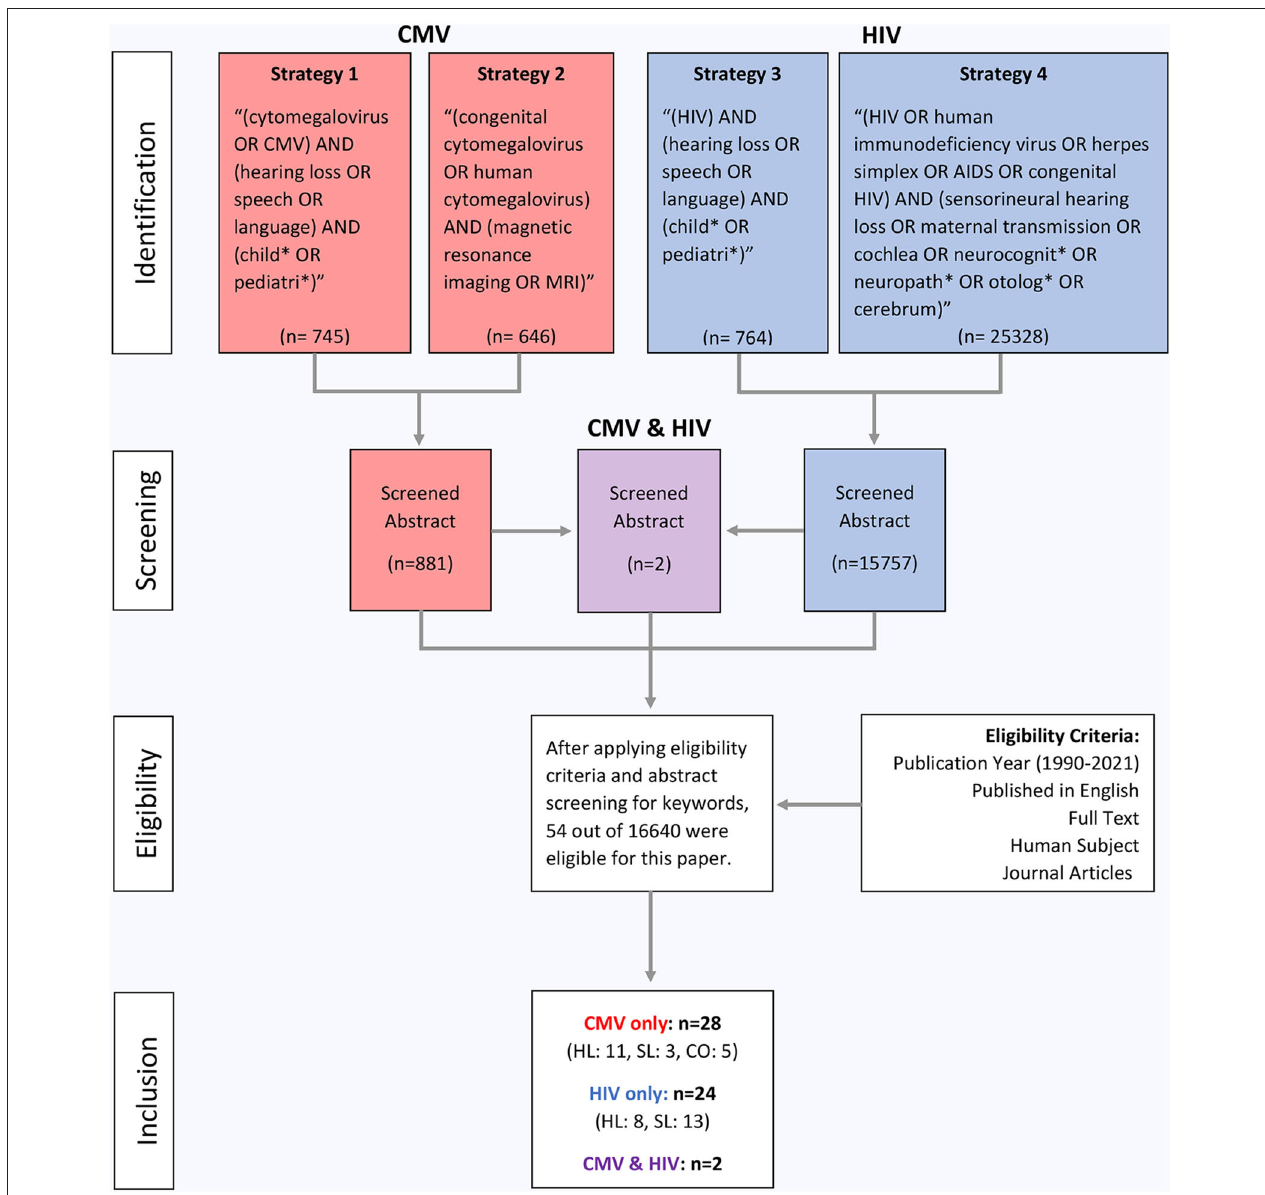
FIGURE 1 | Flow diagram of study inclusion. CMV denotes cytomegalovirus, HIV denotes human immunodeficiency virus, MRI denotes magnetic resonance imaging, HL denotes hearing loss, SL denotes speech/language, and CO denotes clinical